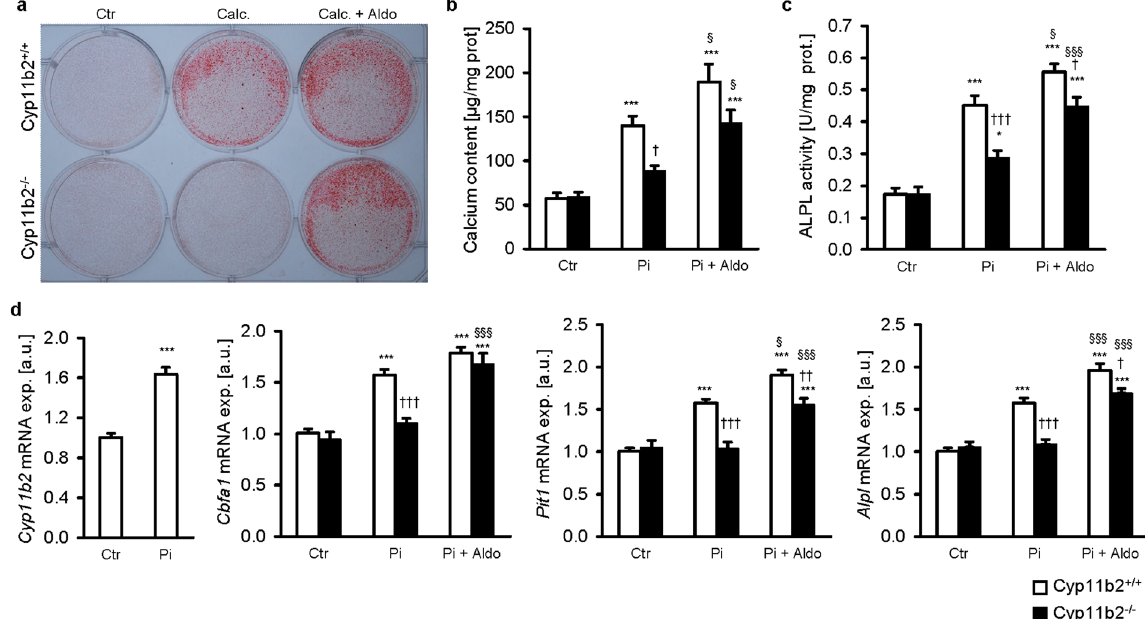
Figure 4. Aldosterone synthase deficiency reduces phosphate-induced vascular calcification in vitro . ( a ) Representative original images showing Alizarin red staining in MAoSMCs isolated from aldosterone synthase-deficient mice (Cyp11b2 − / − ) or corresponding wild-type mice (Cyp11b2 + / + ) treated with or without calcification medium and with or without additional treatment with 100 nM aldosterone (Aldo). Images are representative for three independent experiments. The calcified areas are shown as red staining. Arithmetic means ± SEM of calcium content ( b , n = 9; µ g/mg protein), alkaline phosphatase activity ( c , n = 8; units/mg protein) and of Cyp11b2 , Pit1 , Cbfa1 and Alpl relative mRNA expression ( d , n = 9, a.u.) in MAoSMCs isolated from Cyp11b2 − / − or Cyp11b2 + / + mice treated with (Pi) or without (Ctr) phosphate and with or without additional treatment with 100 nM aldosterone (Aldo). * (p < 0.05), *** (p < 0.001) statistically significant vs. respective control treated MAoSMCs. † (p < 0.05), †† (p < 0.01) ††† (p < 0.001) statistically significant vs.